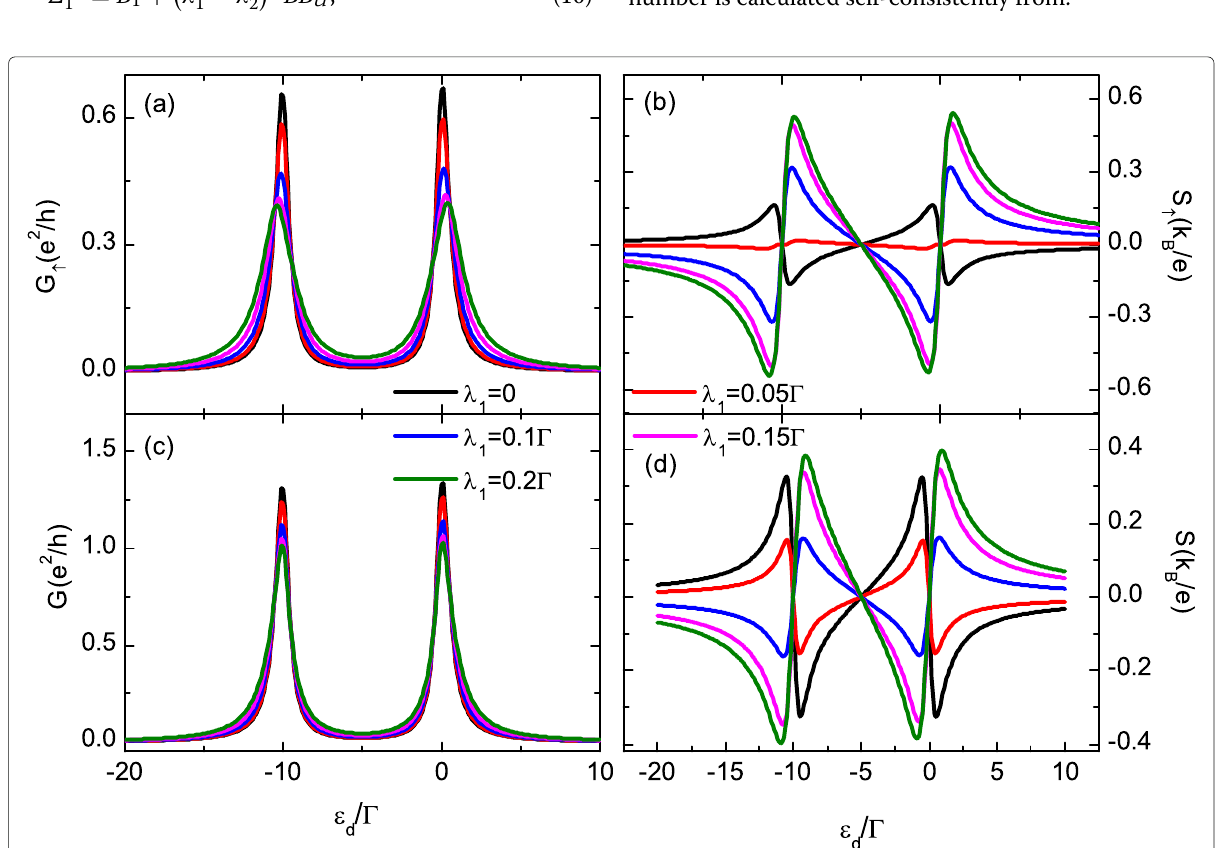
Fig. 2 Spin-dependent conductance and thermopower for different dot-Majorana coupling strengths (color online). The spin-up and total conductance in a , c and thermopower in b , d verse dot-level. The spin-down conductance and thermopower are almost unchanged by the dot-Majorana coupling strength λ 1 , and they overlap with the black solid lines in a and c , respectively. Other parameters are temperature T = 0.025 (cid:6) , (cid:10) M = 0, U = 10 (cid:6) , and λ 2 =